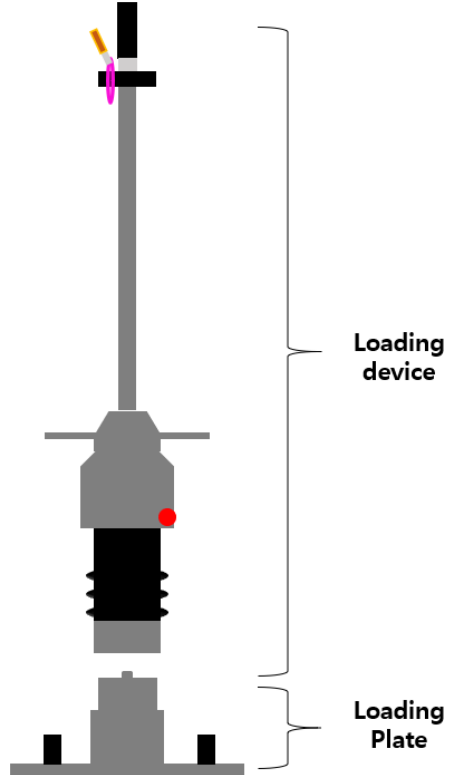
Figure 3. Light-Weight Deflectometer (LWD) equipment composition [34] .